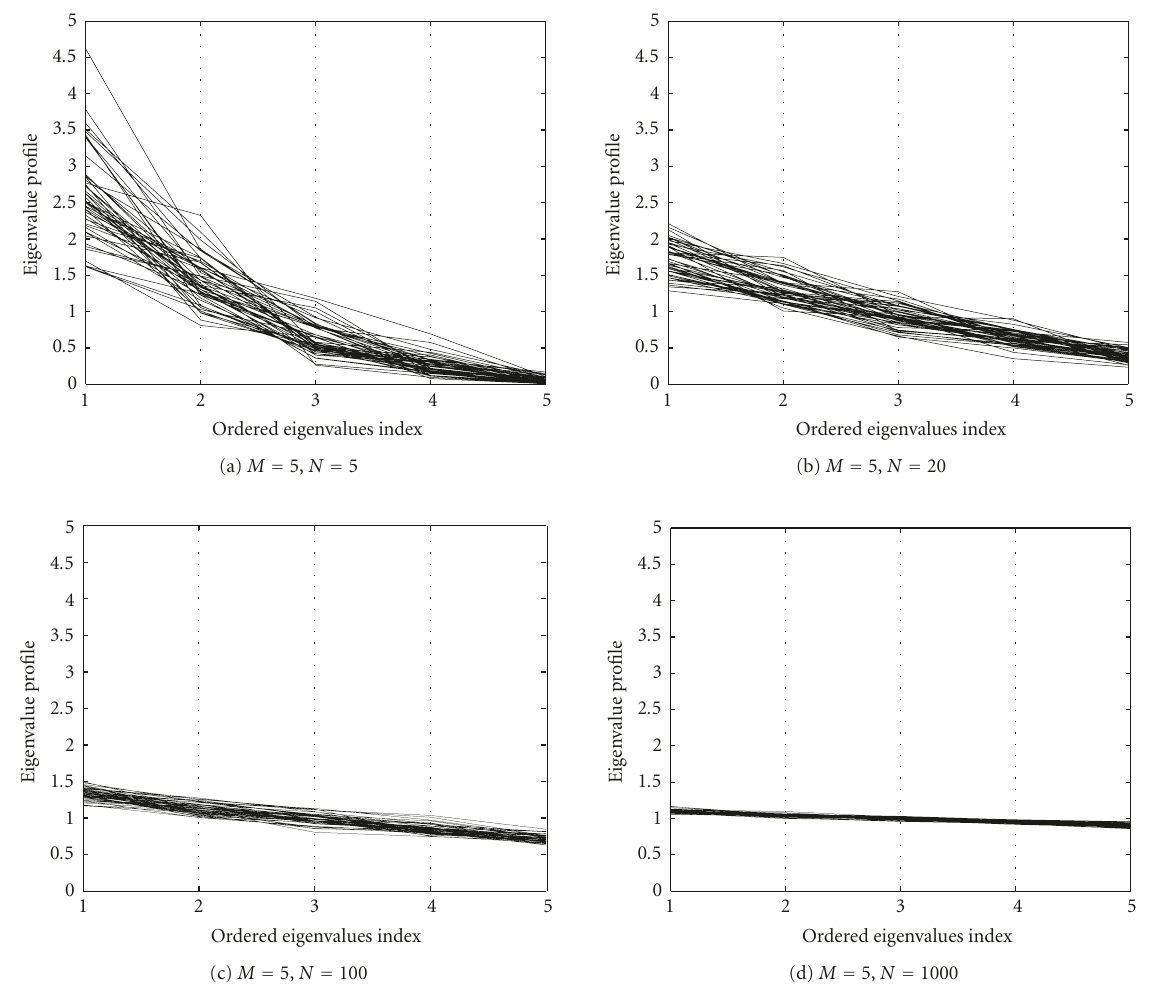
Figure 1: Profile of the ordered eigenvalues under the noise-only assumption for 50 independent trials, with M = 5 and various values of N